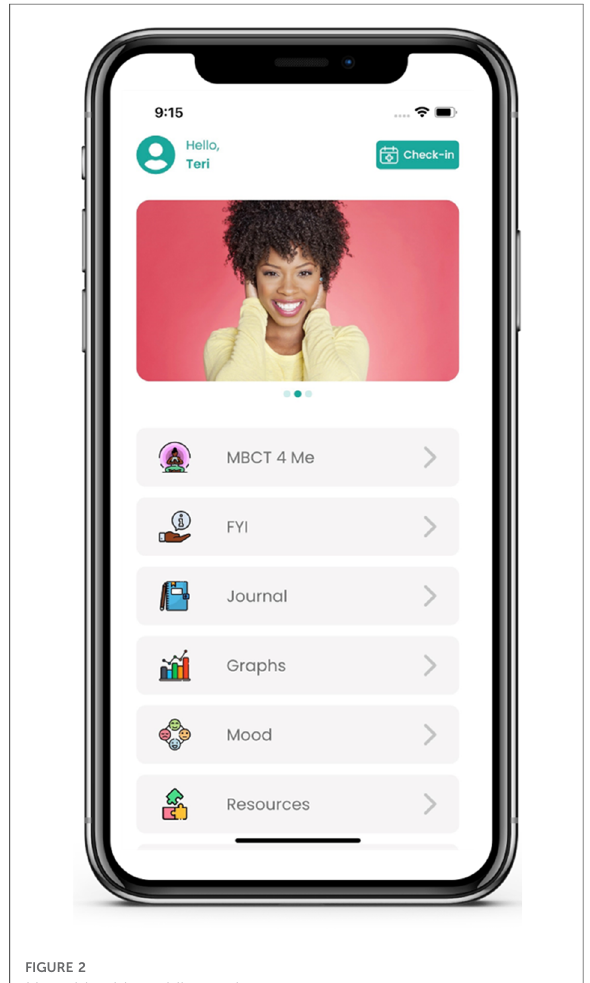
FIGURE 2 Mental health mobile app home